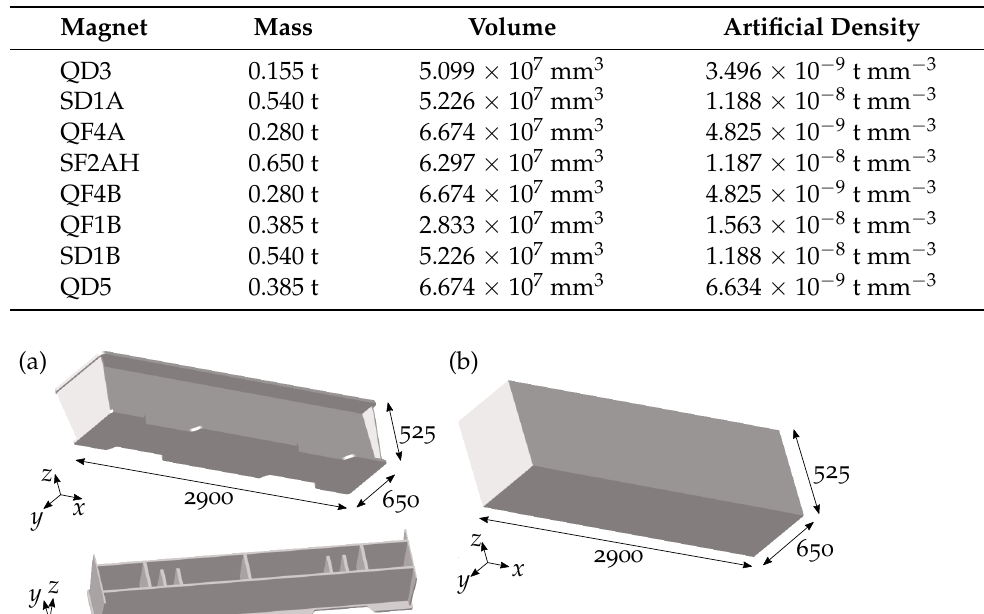
Table 1. Magnet properties including the mass m mag , the volume V mag , and the artificial density ρ mag . Magnet